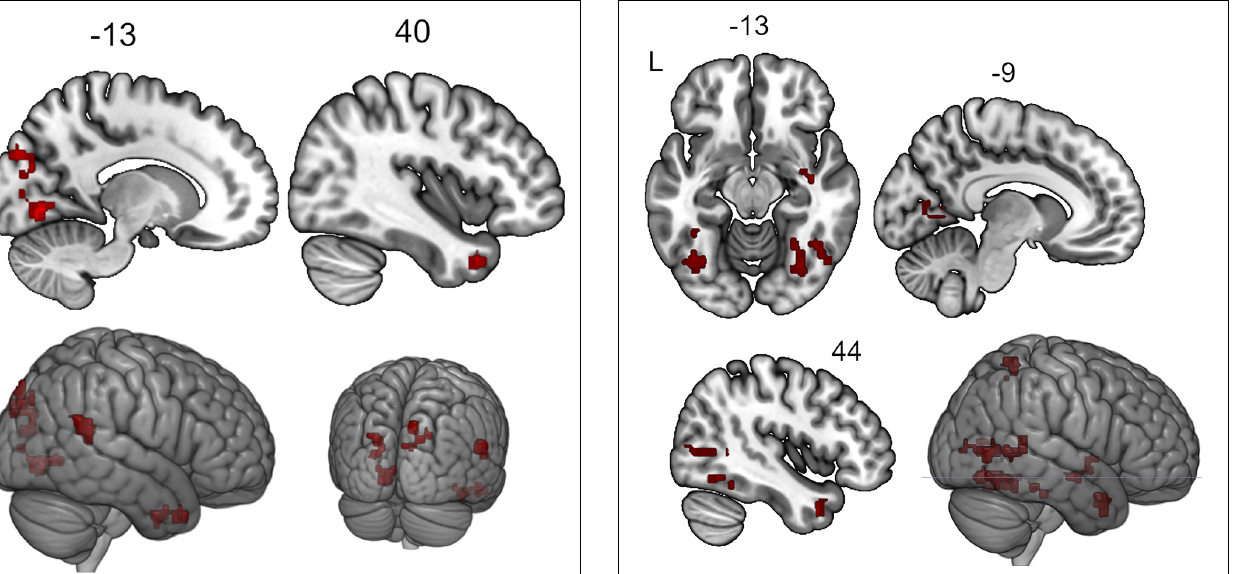
FIGURE 2 | Clusters showing increased connectivity with the left posterior temporal fusiform cortex after neurofeedback. The connectivity map for intrinsic connectivity contrast post- vs. pre-neurofeedback is thresholded at p -FDR < 0.008 at the cluster-level with a cluster-defining voxel-wise statistical threshold of p < 0.001 uncorrected.